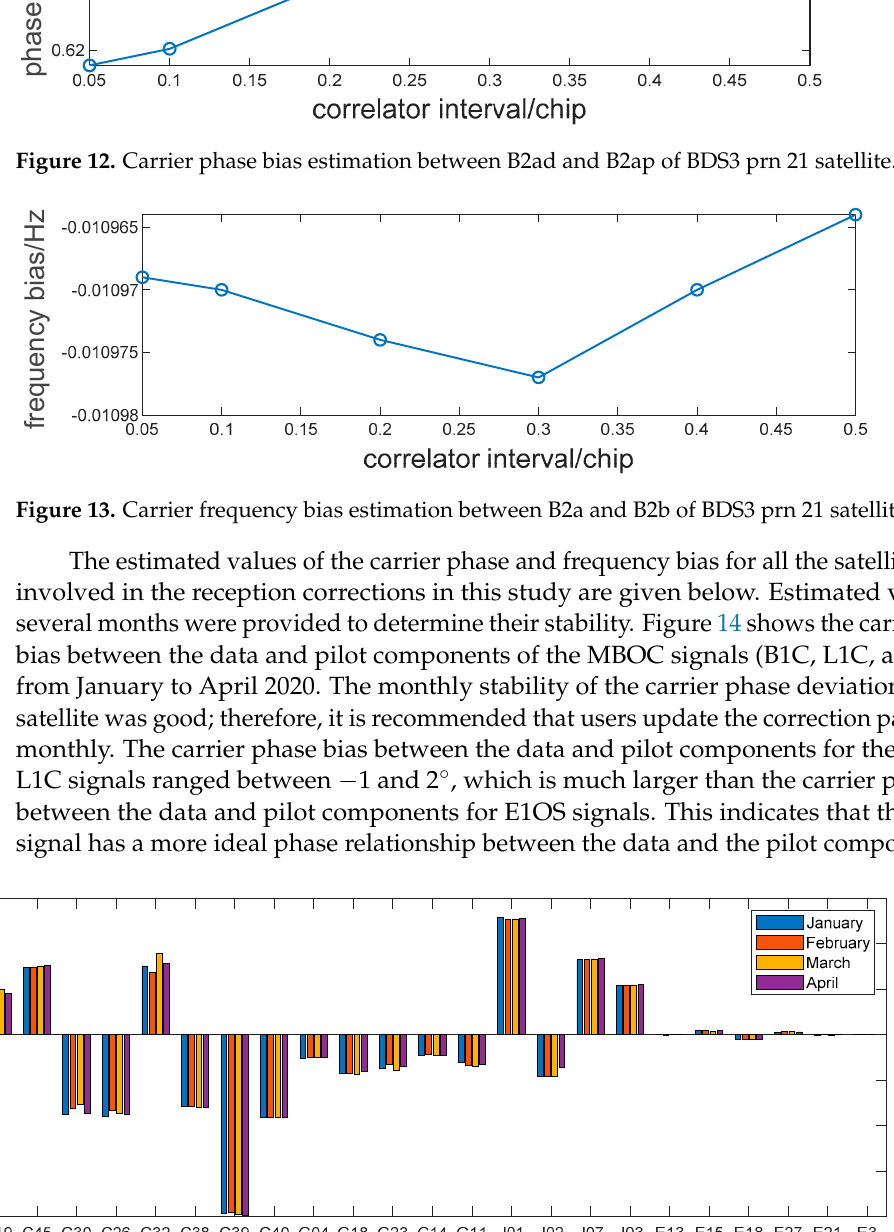
Figure 12. Carrier phase bias estimation between B2ad and B2ap of BDS3 prn 21 satellite.